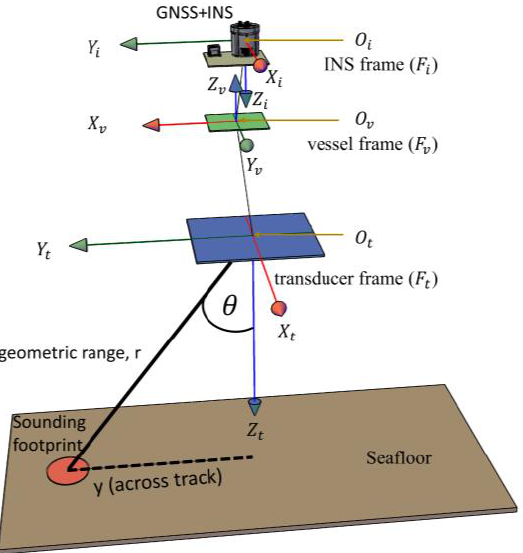
Figure 1. A conceptual overview of MBES footprints’ georeferencing using GNSS + INS mounted on a survey platform with the MBES fixed to the vessel body frame.